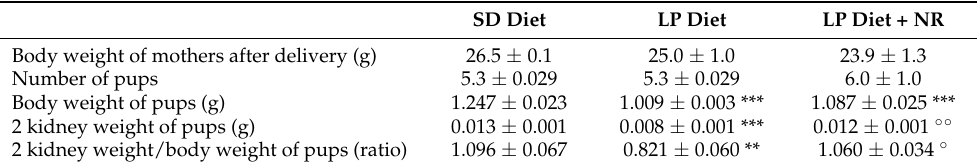
Table 1. Effect of NR supplementation on body and kidney weight of day 1 offspring born to mothers fed LP